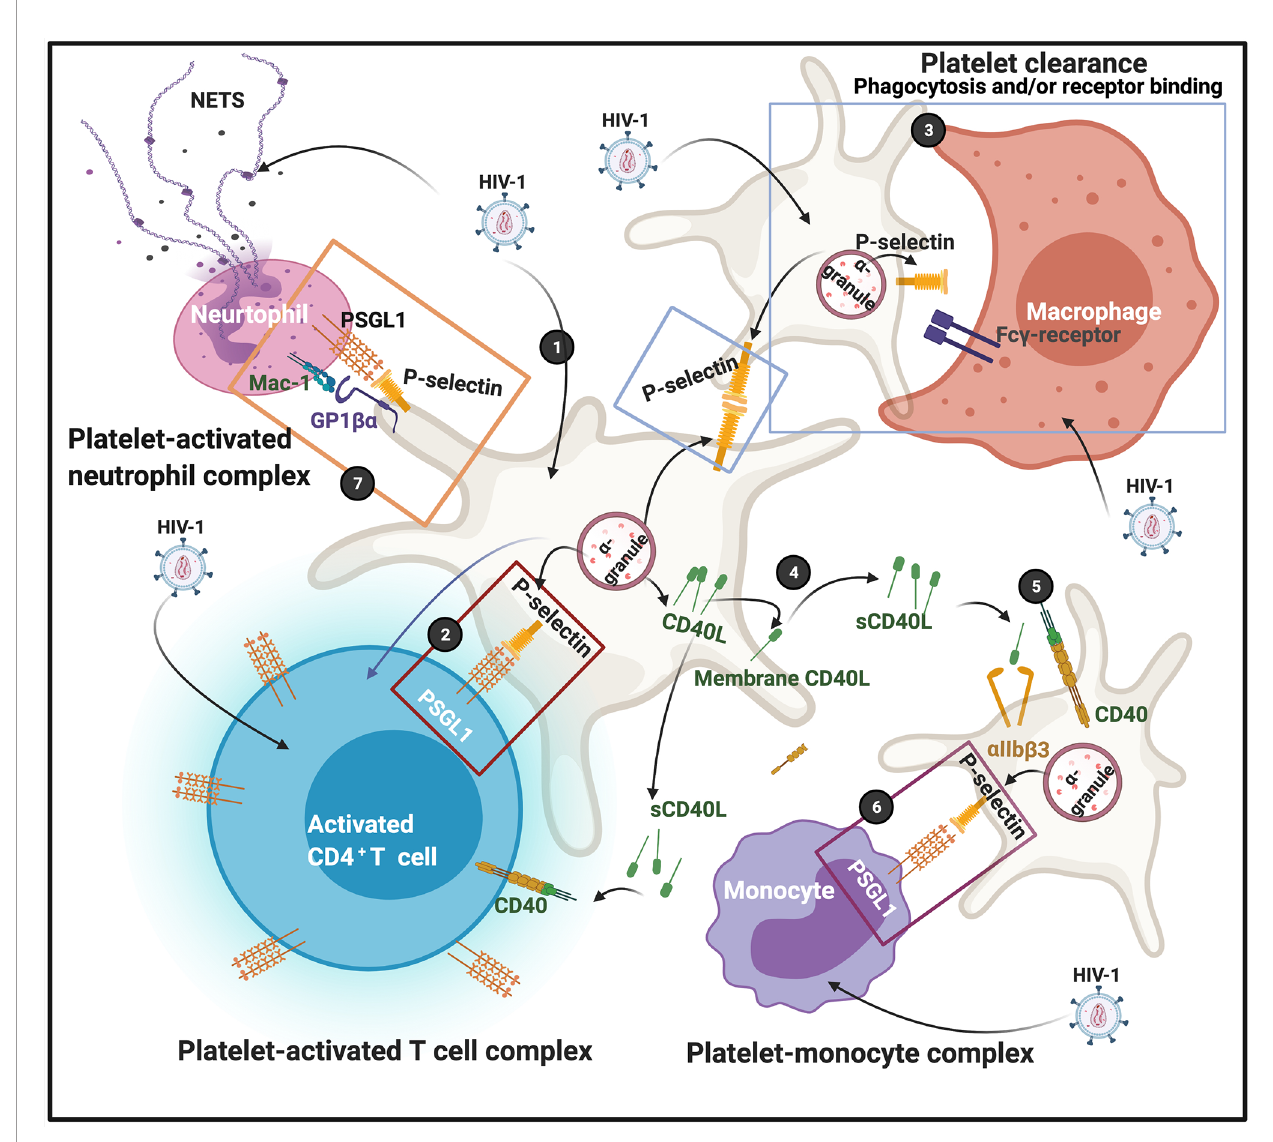
FIGURE 4 | (1) After virus endocytosis, platelets express P-selectin on their membranes, followed by platelet-T cell complex formation (2); P-selectin on platelet membranes are also recognized by macrophages, possibly by the Fc g -receptor; clearance may result due to either receptor binding or phagocytosis (3). CD40L is released from platelets and can migrate to membranes or shed as soluble (s)CD40L (4). sCD40L can bind to both the a IIb b 3 or CD40 receptors (5) The P-selectin on the membranes of sCD40L-activated platelets can also form complexes with monocytes (6). Platelet-neutrophils also form complexes (7) Diagram created with BioRender